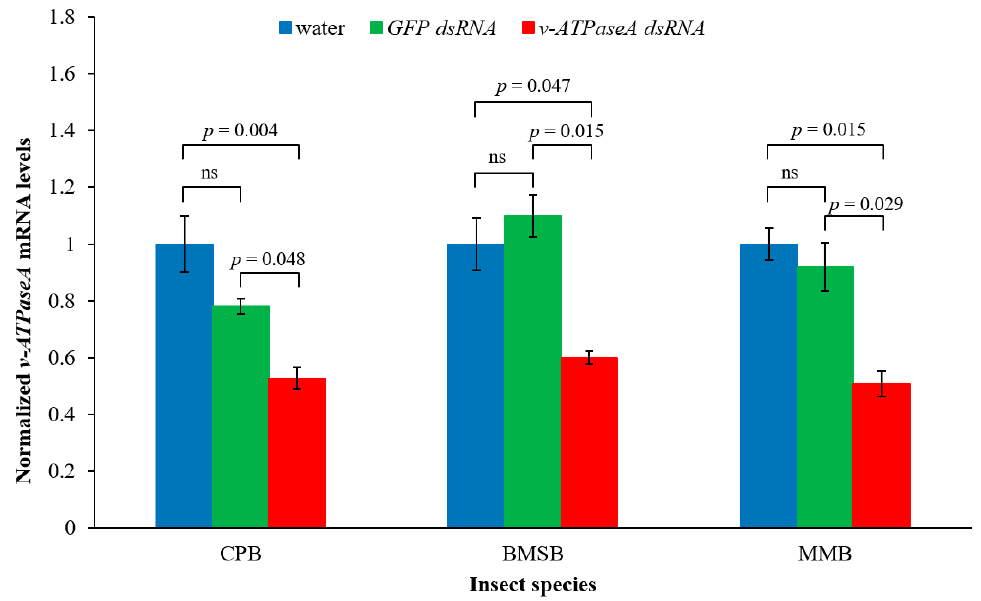
Figure 1. Down-regulation of v-ATPaseA gene in three insect species when treated with in vitro- synthesized 189 bp dsRNA based on cotton mealybug v-ATPaseA . CPB larvae were fed dsRNA or water coated on potato leaves while BMSB and MMB adults were injected with dsRNA or water. Normalized mRNA levels in water treatment were set to the value “1.0”, and the mRNA levels in GFP and v-ATPaseA treatments were calculated relative to the water treatment. RT-qPCR data are expressed as mean relative quantity ± SEM, n = 3. p -values were calculated using Tukey’s HSD (one-way ANOVA) for each comparison and are indicated on the graph. CPB = Colorado potato beetle; BMSB = brown marmorated stink bug; MMB = Madeira mealybug. “ns” = not significant ( p > 0.05) according to Tukey’s HSD